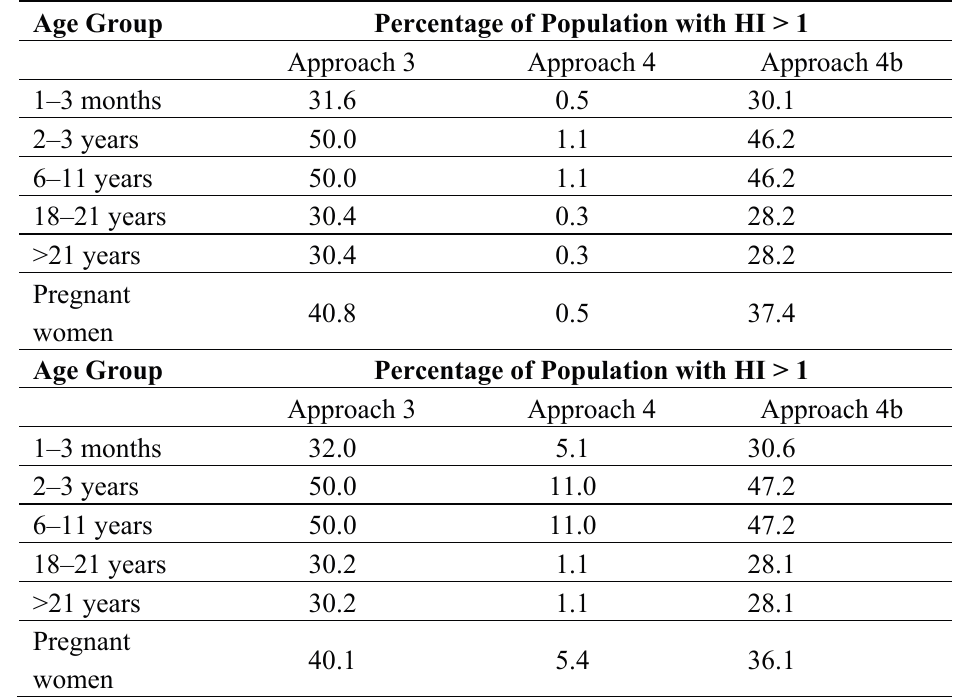
Table 2. Percentages of the population in each age group that exceeds a Hazard Index (HI) of 1 under existing concentrations of perchlorate + nitrates + thiocyanates in water and food. Reference Dose (RfD) values used are as reported in Section 2. The upper table contains the results without half-life correction, and the lower table presents the same results with half-life